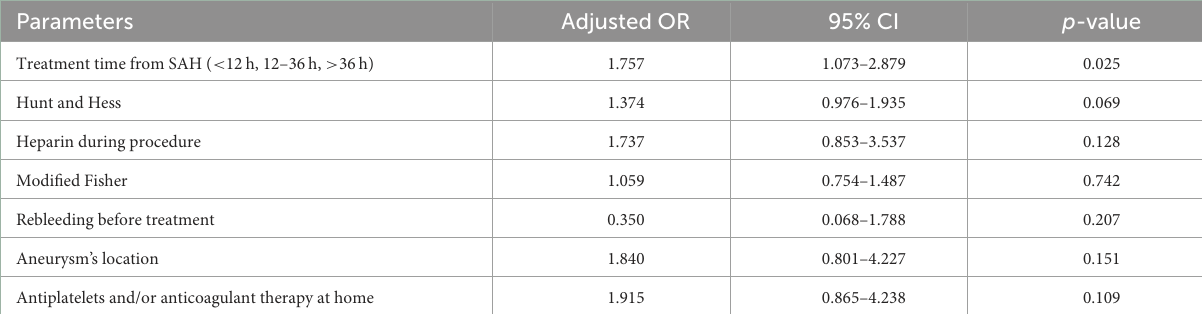
TABLE 2 Multivariate logistic regression models for identification of clinically relevant predictors of aneurism treatment complications. Parameters Adjusted